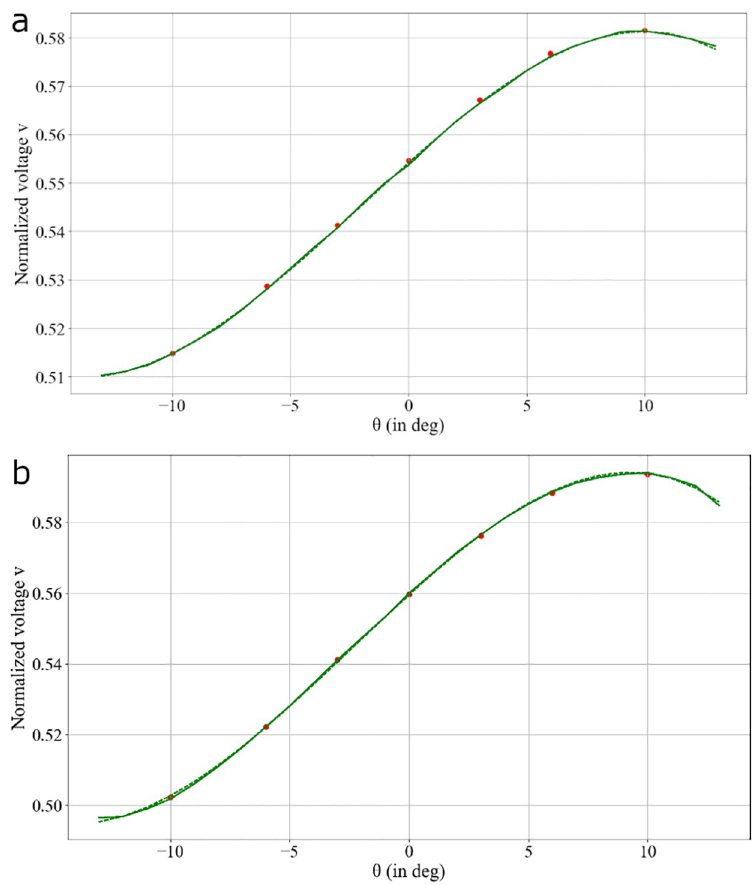
Fig 9. PSD measurements as a function of gaze direction for two CLP-PSD distances: (a) 1.5 cm and (b) 2 cm. The continuous line represents the experimental data and the dashed line the fitted model.